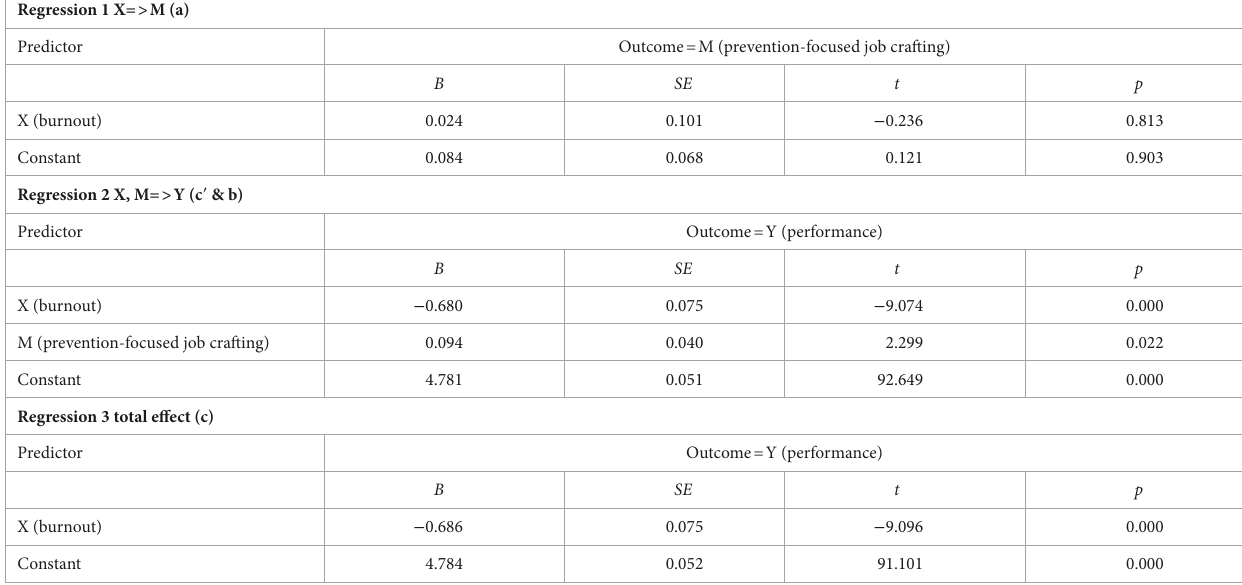
TABLE 4 Analysis of prevention-focuses job crafting mediation on the influence of burnout on performance (simple mediation model for prevention- focuses job crafting). Regression 1 X= > M (a)